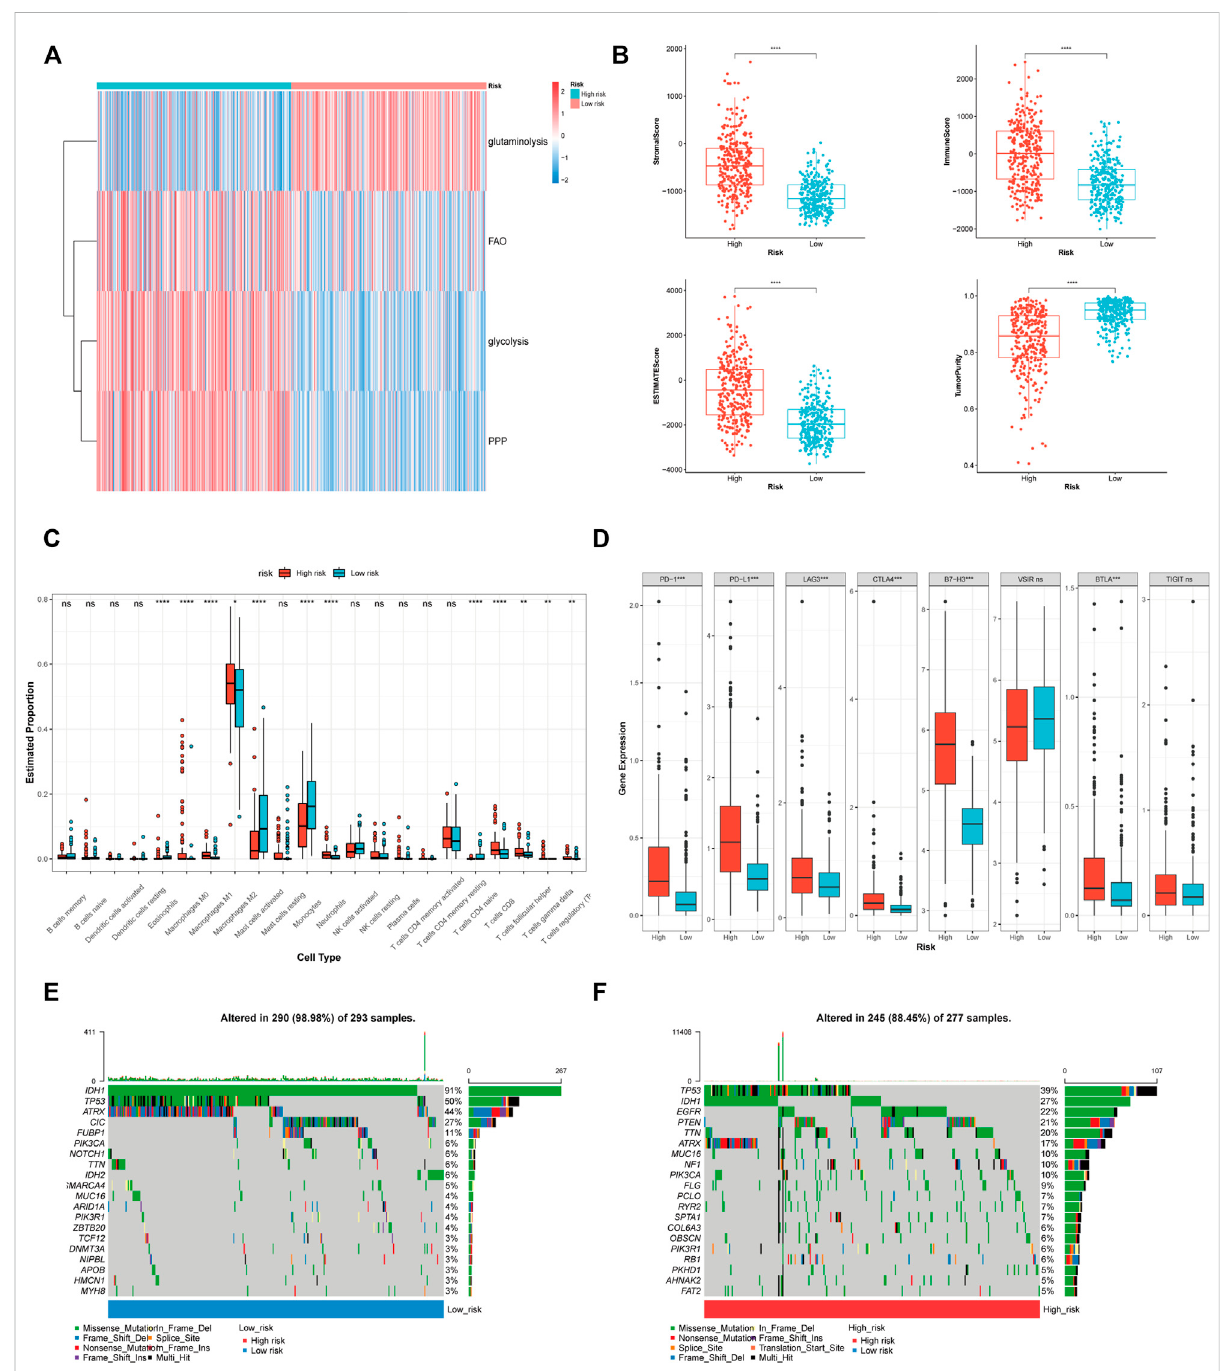
FIGURE 7 The correlation of PRL classi fi er with heterogeneous microenvironment in the TCGA cohorts. (A) GSVA showing the differences in the energy source between high and low risk group. (B) Comparison of the stromal, immune, and ESTIMATE scores, as well as the tumour purity between the high- and low-risk groups. (C) The abundance of 22 immune cells in the high- and low-risk groups. (D) The expression levels of the immune checkpointsinthehigh-andlow-riskgroups. (E,F) Thetop20genesmutationwerevisualizedinthehigh-andlow-riskgroups.* p < 0.05,** p < 0.01, and *** p < 0.001. ns, no signi fi cance. FAO, fatty acid beta oxidation; PPP, pentose phosphate